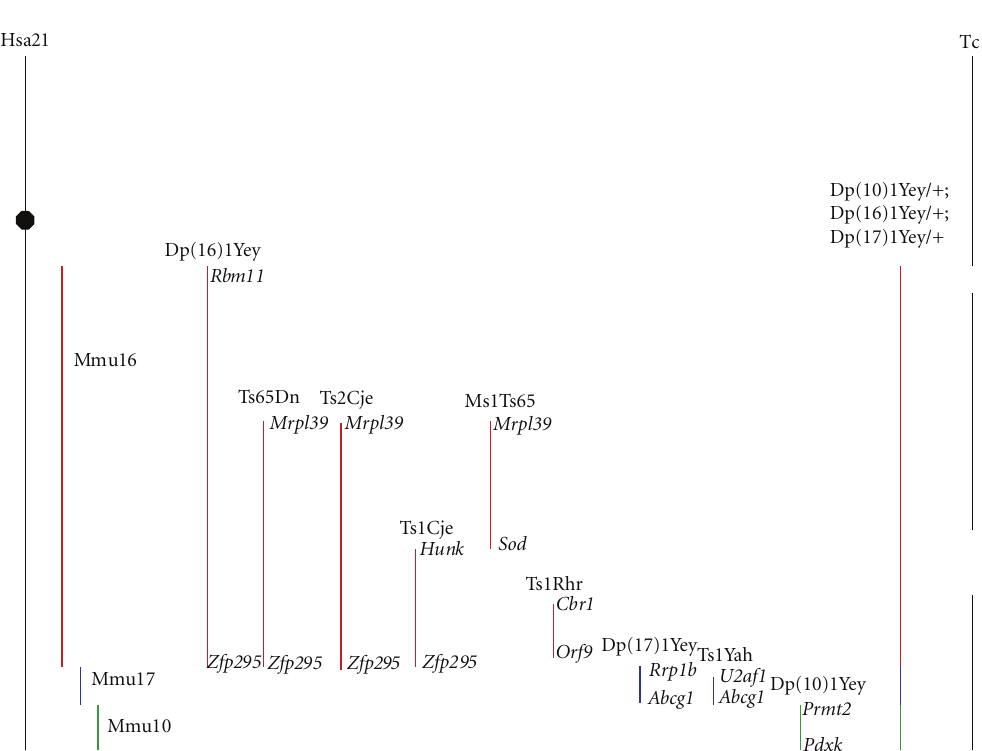
Figure 1: Schematic representation of Hsa21 and syntenic regions of Mmu16, Mmu17, and Mmu10 and the di ff erent mouse models trisomic for di ff erent sets of genes orthologous to those of Hsa21. The flanking genes found at the boundaries of the triplicated region in each model are written in italics. Modified from [3,